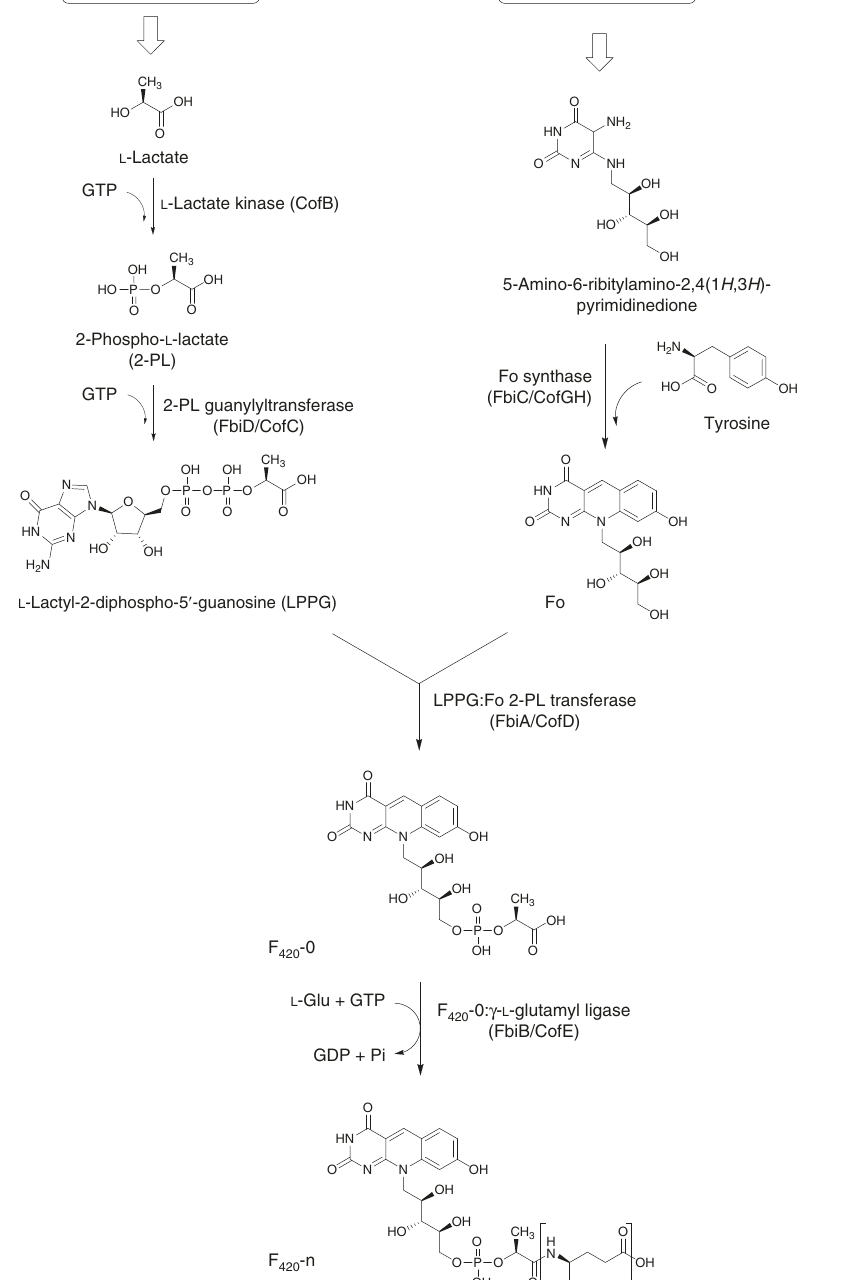
To understand the molecular basis of PEP recognition by Mtb - FbiD, we crystallized the protein and solved the structure by selenium single-wavelength anomalous diffraction (Se-SAD), and then used this selenomethionine-substituted structure to obtain